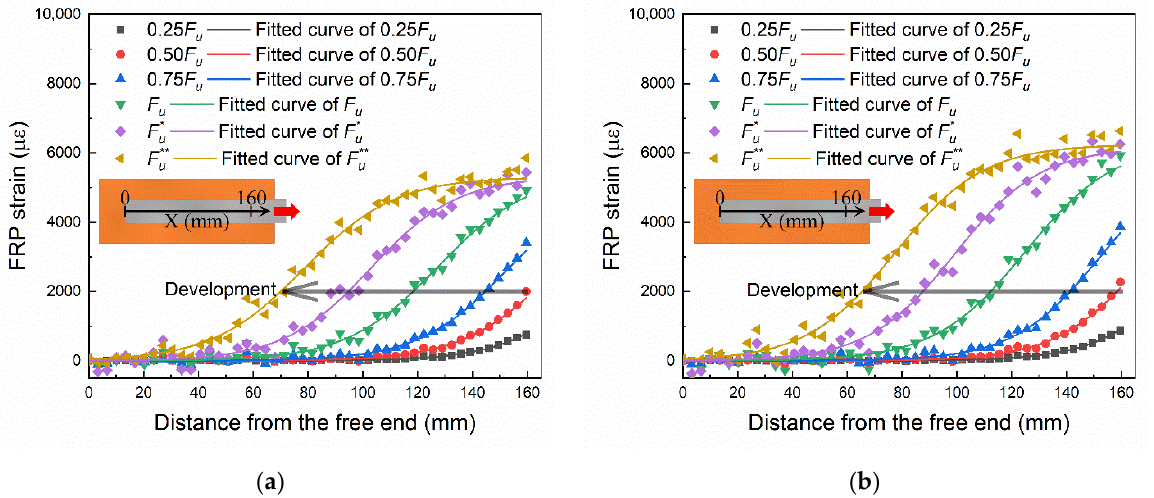
Figure 7. The strain distribution data and the fitted curves of: ( a ) specimen A4 (10 mm/min); ( b ) specimen B2 (1000 mm/min).